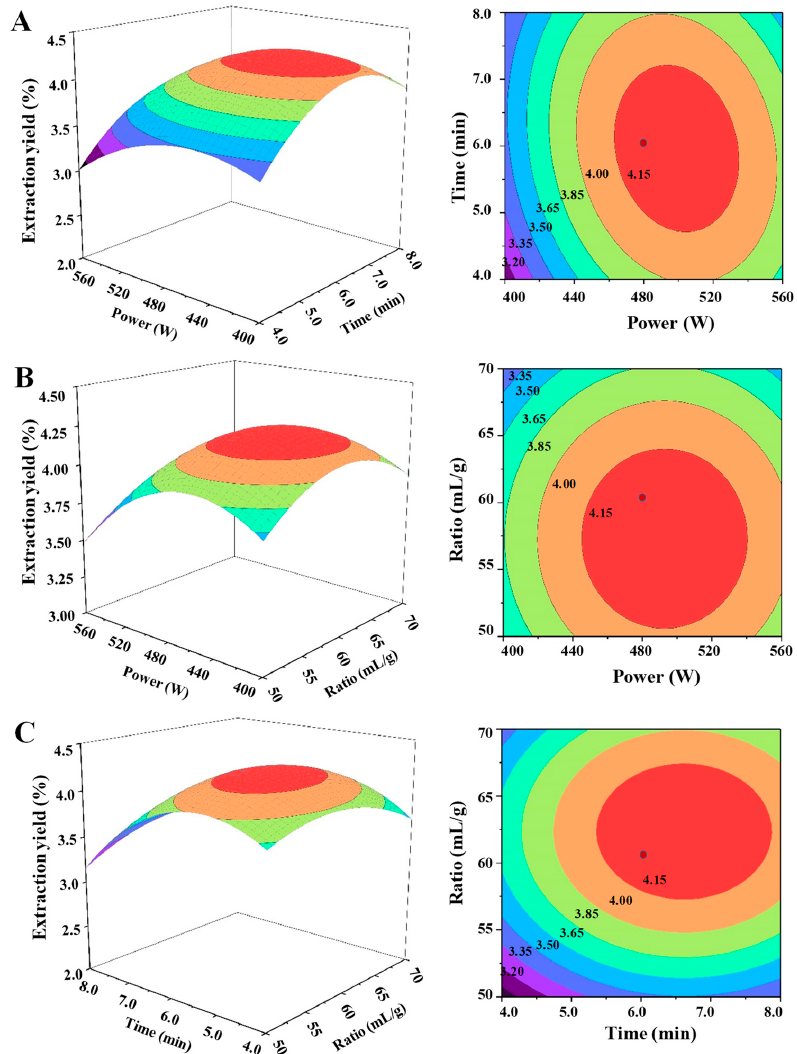
Figure 3. The three-dimensional response surface (left) and two-dimensional contour (right) plots of microwave assisted extraction: ( A ) microwave power and extraction time; ( B ) microwave power and the ratio of water to raw material; and ( C ) extraction time and the ratio of water to raw material.